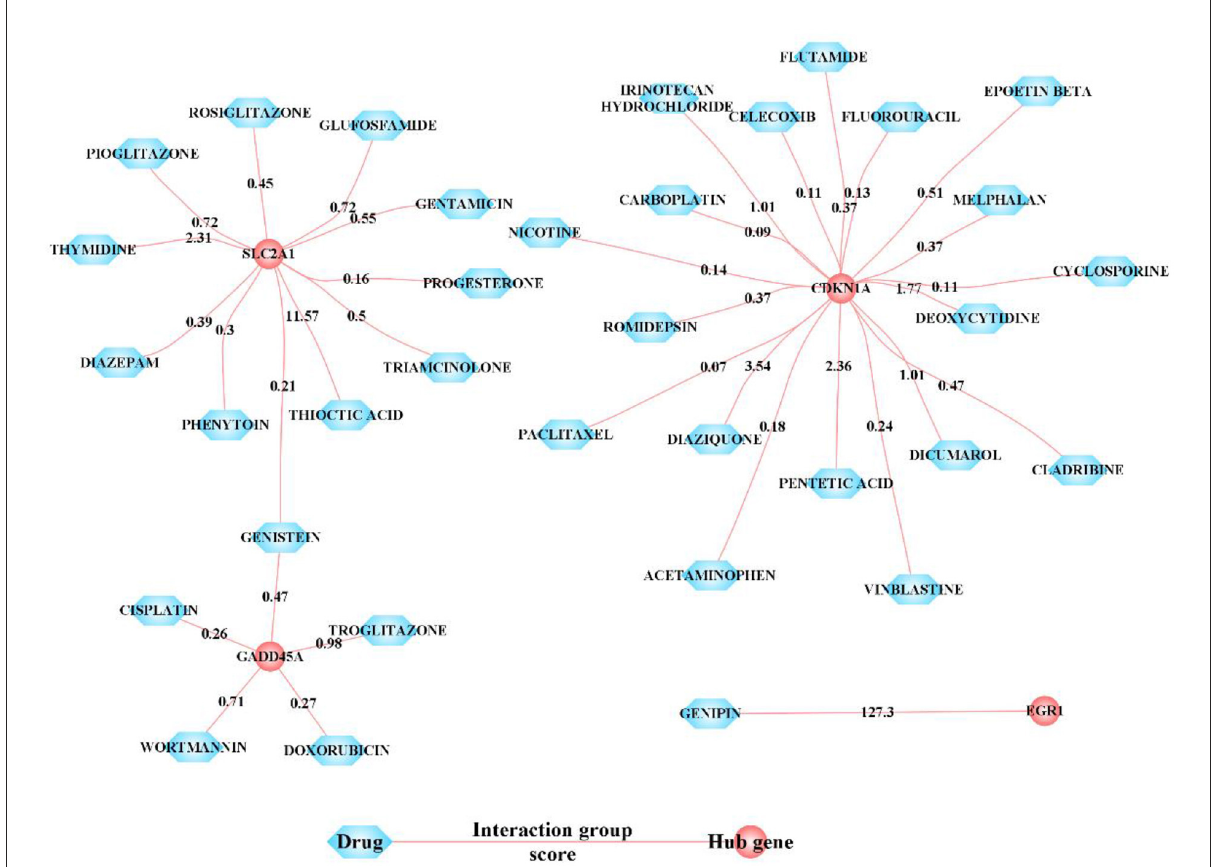
FIGURE9 Sensitivity relationship between hub cross talk gene and Drug. In the network, nodes with interaction group score ≥ 4 are displayed, and other nodes are hidden. The interaction score is a static score and based on the evidence of an